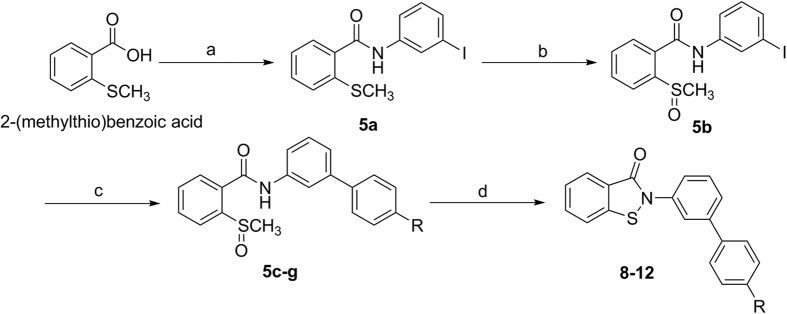
General synthetic strategy for inhibitors 8–12.(a) SOCl2 (3.0 eq), toluene, DMF, reflux, 2–3 hours: then 3-iodoaniline (1.2 eq), Et3N (2.0 eq), THF, 10 minutes at 0 °C, 20 hours at 22 °C; 98% yield. (b) NaIO4 in H2O (1.6 eq), MeOH, 50 °C, 4–5 hours; 96% yield. (c) Phenyl boronic acid (1.2 eq), K2CO3 (3.3 eq), [Pd(PPh3)4] (0.025 eq), H2O:THF (1:2), 80 °C, 18–22 hours; 80–87% yield. (d) SOCl2 (1.3 eq), DCM, 50 °C, 1.5 hours; 35–74% yield.